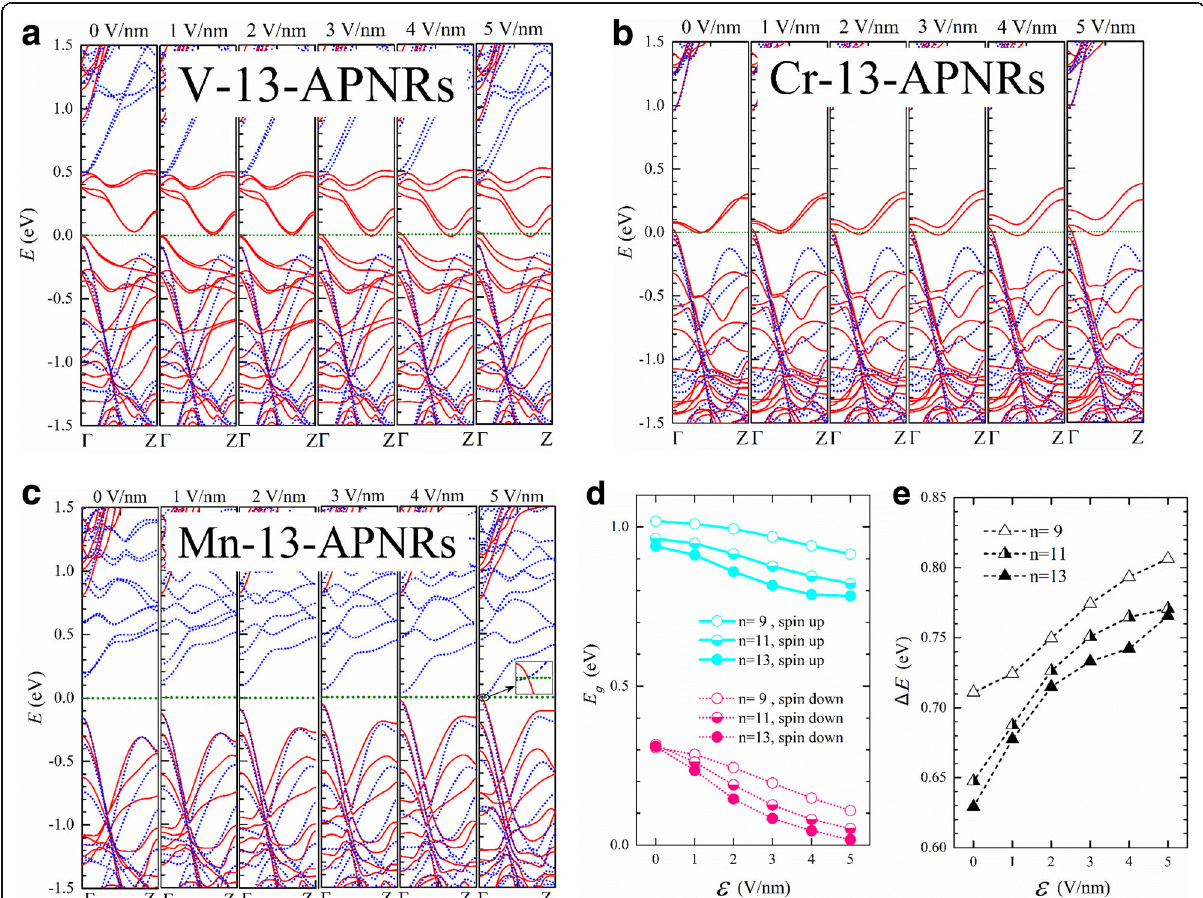
Fig. 6 The spin-up (solid) and spin-down (dotted) band structures of a V-, b Cr-, and c Mn-13-APNRs under a transverse electric field of strength E ¼ 0 ; 1 ; … ; 5 V/nm. d The band gaps of Mn- n -APNRs versus E for up spin ( E up and 13. e The gap difference Δ E ¼ E up